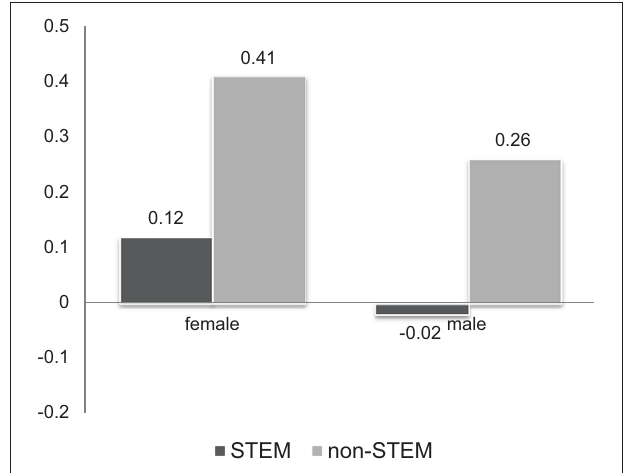
FIGURE 3 | Masculinity index of math and career aspirations.